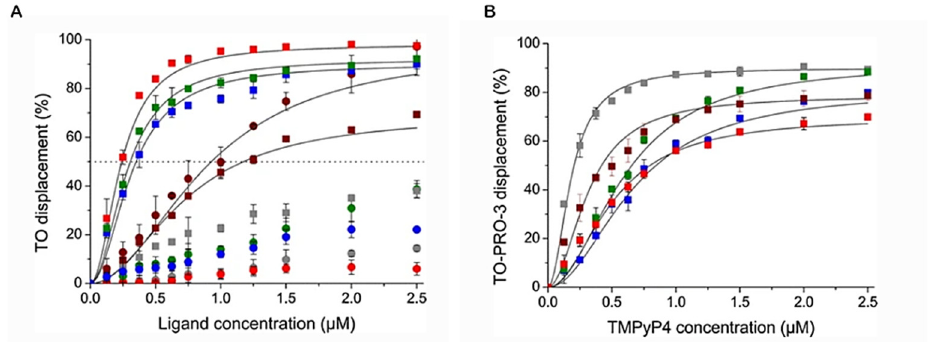
Figure 23. ( A ) Representative G4-FID curves obtained with MMQ1 (gray), MMQ3 (brown), Pt-ttpy (red), 360A (blue) and Phen-DC3 (green) with 22AG.K (squares) and ds26 (circles) using TO as fluorescent probe. ( B ) Representative G4-FID curves of TMPyP4 with 22AG.Na (blue), 22AG.K (red), c-kit1 (brown), c-kit2 (gray), and ds26 (green) with TO-PRO-3 as fluorescent probe. For each well of the microplate were added: (i) K + - or Na + -buffer solution; (ii) oligonucleotides (5 μ M) and fluorescent probe (TO or TO-PRO-3; 10 μ M for G4-DNA or 15 μ M for ds26) and (iii) an extemporaneously prepared 5 μ M ligand solution in K + - or Na + -buffer. The final volume in each well was 200 μ L. Reprinted with permission from ref. [206] Copyright 2011 Springer Nature.